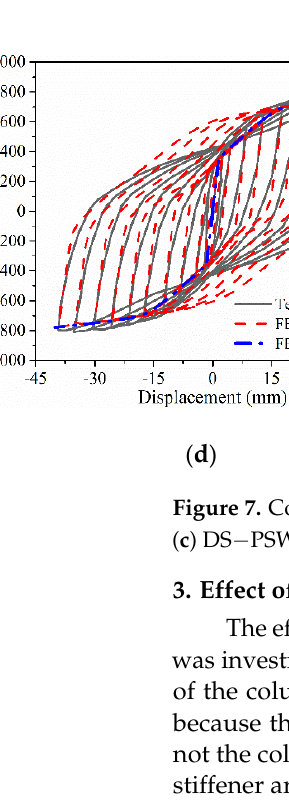
( e ) Figure 9. Hysteretic curves for SPSW1 − 3VHS with different η: ( a ) η = 10; ( b ) η = 30; ( c ) η = 60; ( d ) η =90; ( e ) η = 120.